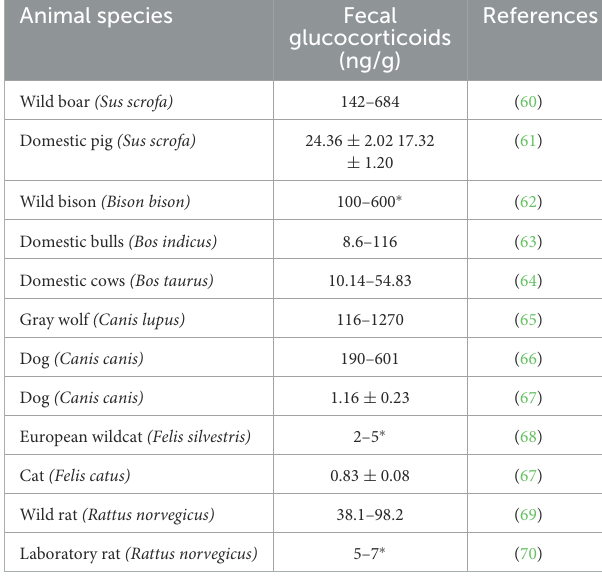
TABLE 1 Fecal glucocorticoid concentrations in wild animals and related domestic animal